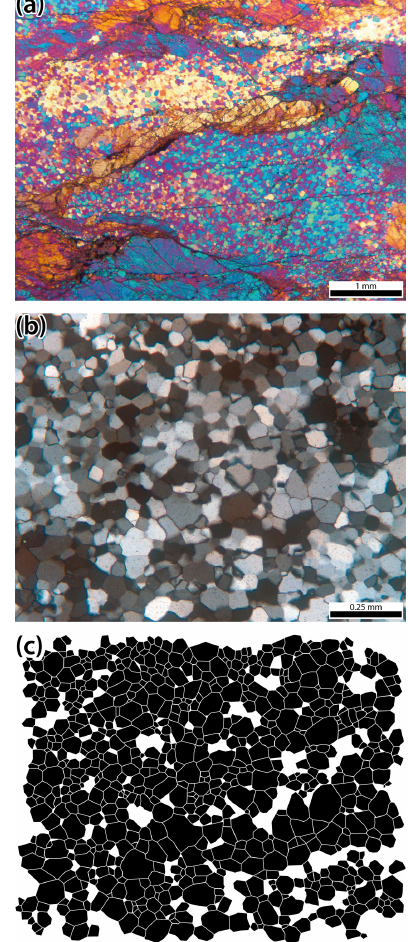
Figure 8. Quartz microstructure in sample MAL-05. (a) Generic view of Penedo Gordo mylonites under the optical microscope (crossed polars, gypsum plate inserted). Note that original quartz grains are almost fully recrystallized and have a strong lattice pre- ferred orientation. (b) Optical micrograph (crossed polars) showing dynamically recrystallized quartz grains. (c) Digitized quartz grains from the micrograph (b) . This is data set 02 in Fig. 10.